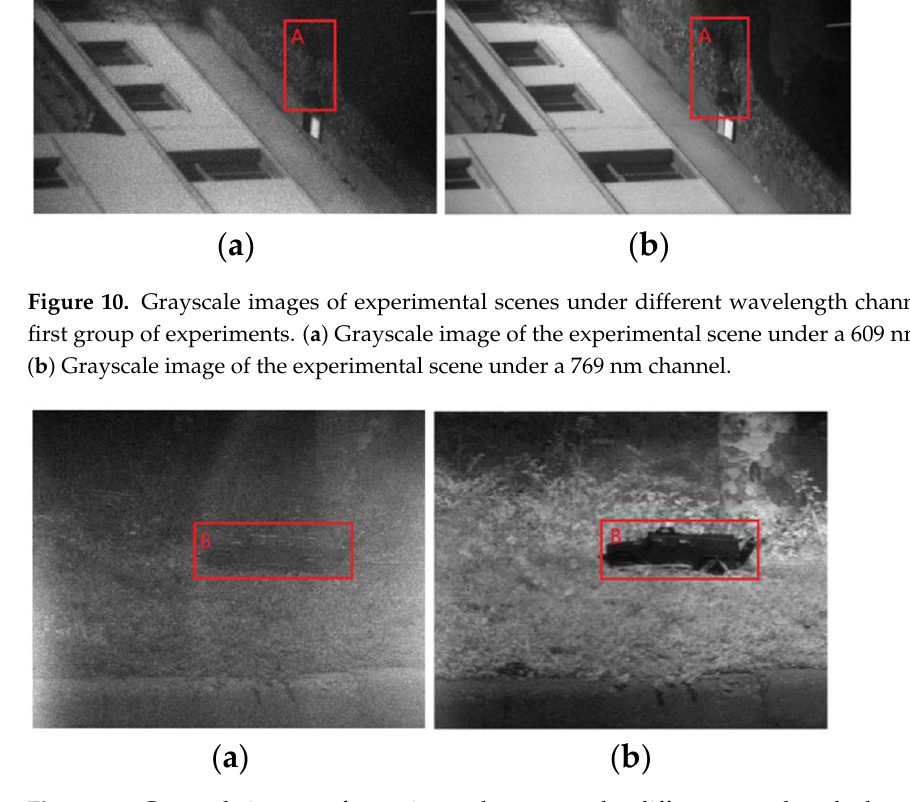
Figure 11. Grayscale images of experimental scenes under different wavelength channels in the second group of experiments. ( a ) Grayscale image of the experimental scene under a 609 nm channel. ( b ) Grayscale image of the experimental scene under a 769 nm channel.